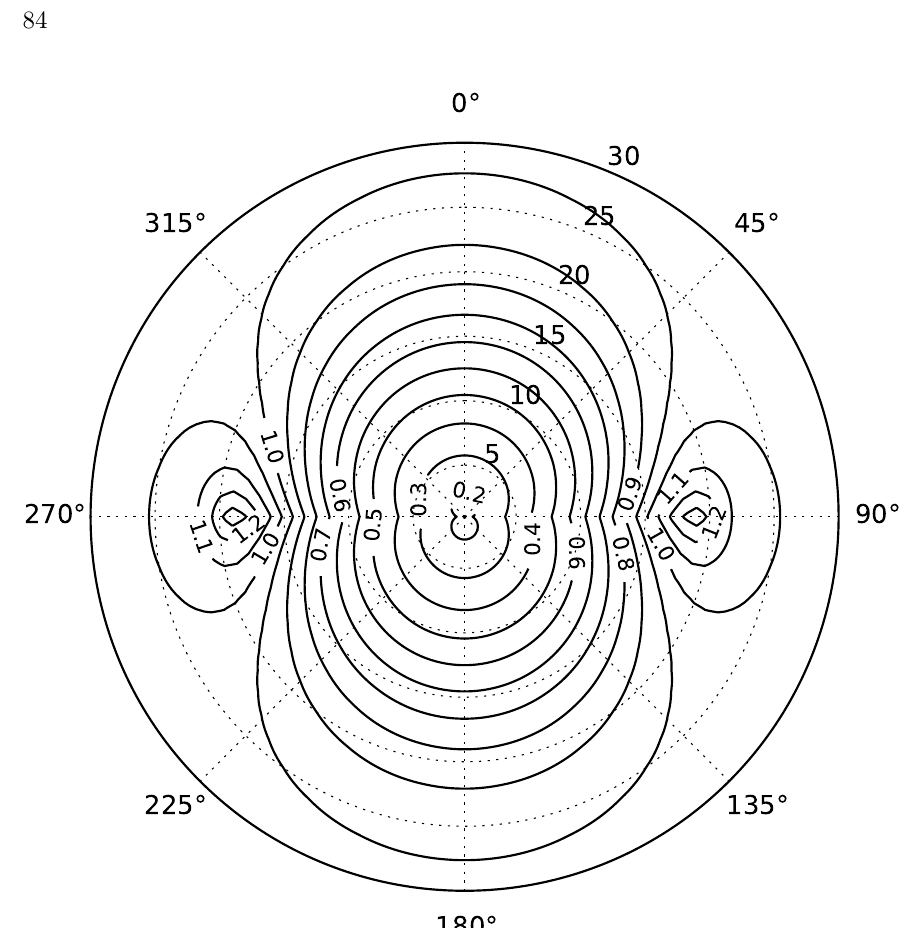
Fig. 1. Isolines of the correction factor of the gravitational potential, C U . The coor- dinates are the scaled logarithm of the distance in the units of the circular disk galaxy radius, given in units iD (cid:1) 0 : 05 (cid:0) 1 : 0. The distances from D = 0 : 1 to iD = 30, i.e. p D = 10, have been covered. The maximum correction factors are on the galactic plane at D = 1. At this point the asymmetry of mass distribution along the plane of circular disk galaxies has the maximal value. In the outer region free of isolines the value of C U has its asymptotic value approaching to 1.0. The central value of the correction factor is